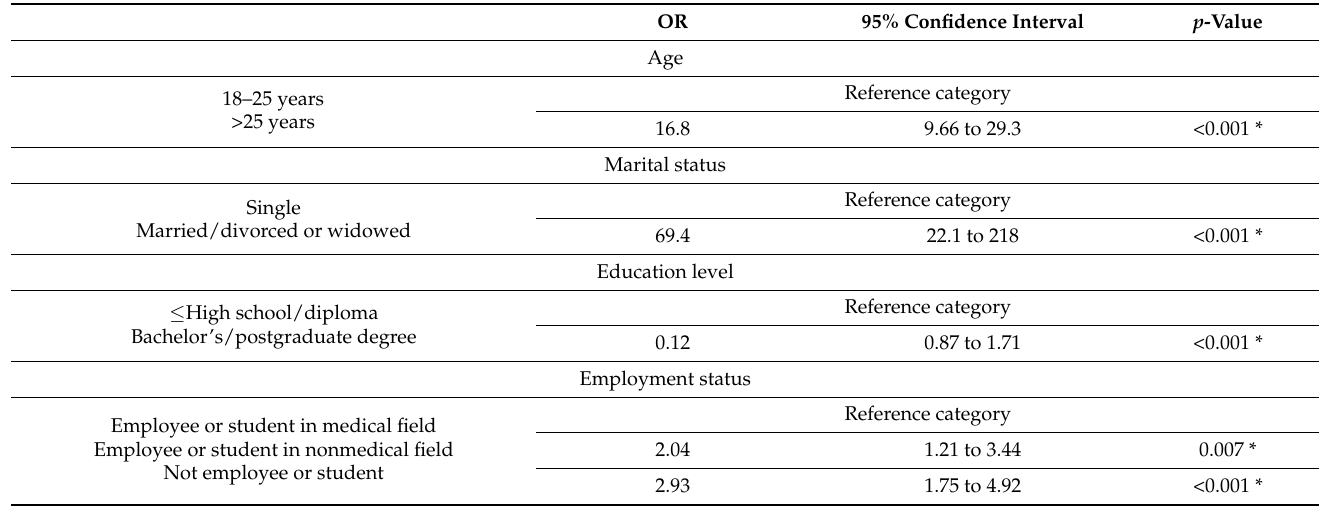
Table 4. Predictors of performing the pap smear test.